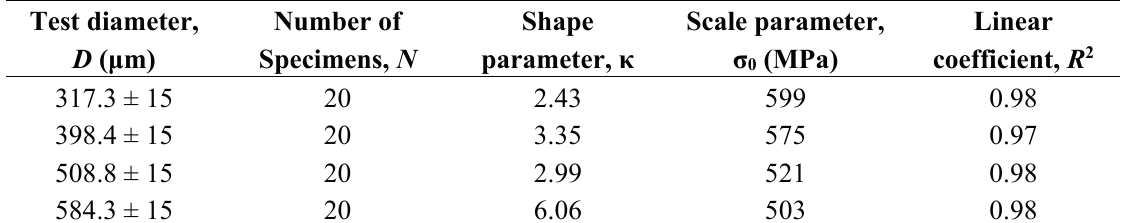
Table 2. Weibull parameters for the tensile strength of bamboo fiber at different test diameters.